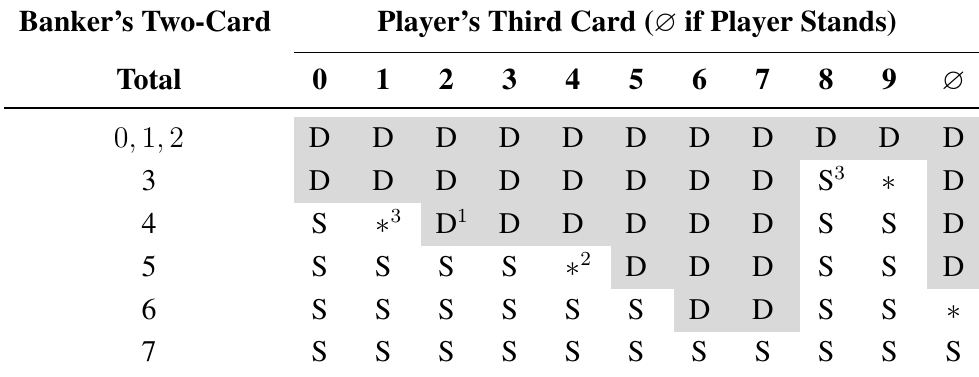
Table 2. Banker’s optimal move (preliminary version) under Model B1 with d = 6 , indicated by D (draw) or S (stand), except in the n Player’s strategy. Adjustments to the table for other positive integers d are specified by footnotes. Under Model A1, results are the same as those under Model B1 with d